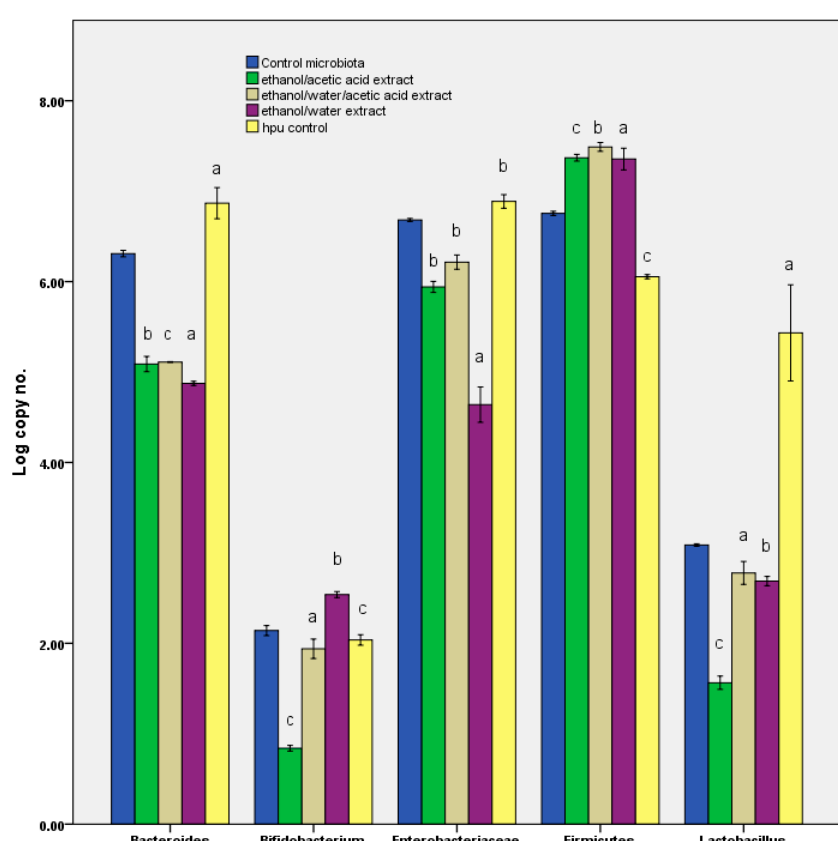
Figure 4. Log of number of copies obtained after in vitro tests through GIS1 as a measure of the impact of curcuma extracts on the number of the main groups of microorganisms from human gut. Different letters mean significant statistical differences ((control microbiota vs. treated samples/hpu; a = p ≤ 0.05; b = p ≤ 0.01; c = p ≤ 0.001), n = 3).